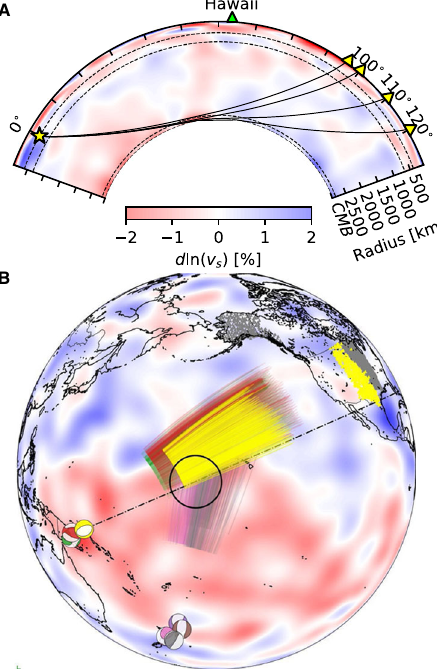
Fig. 1 Events and Sdiff ray paths used in this study. A Cross-section slicing the center of Hawaiian ultra-low velocity zone, showing ray paths of S diff waves at 96°, 100°, 110°, and 120° for 1D Earth model PREM 49 . The dashed lines from top to bottom mark the 410 km, 660 km discontinuity, and 2791 km (100 km above the core – mantle boundary). B Events and S diff ray paths on the background tomography model SEMUCB_WM1 at 2791 km depth 50 . Beachballs of events plotted in different colors including 20100320 (yellow), 20111214 (green), 20120417 (red), 20180910 (purple), 20180518 (brown), 20181030 (pink), 20161122 (gray), stations (triangles), and ray paths of S diff waves at pierce depth 2791 km in the lowermost mantle used in this study. The event used in short-period analysis is highlighted in yellow. Proposed ULVZ location is shown in black circle. Dashed line shows cross-section plotted in A .